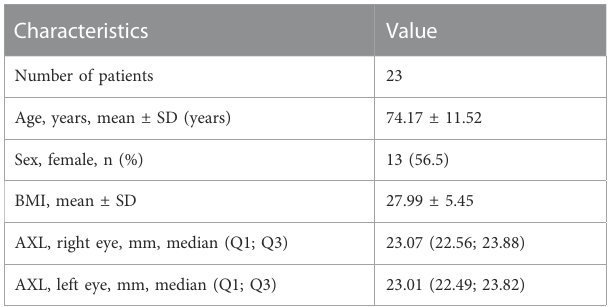
TABLE 1 Baseline patient